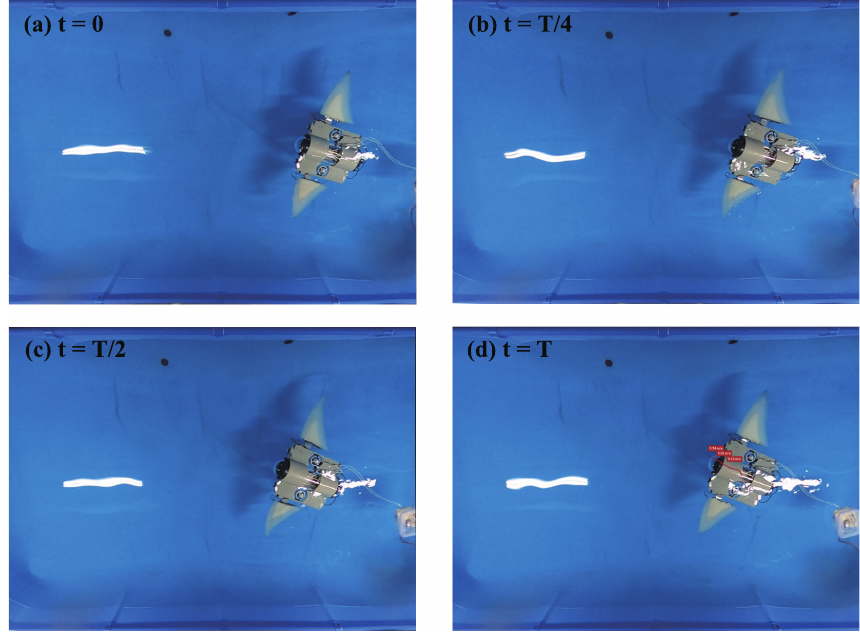
Figure 16. The experiment without in the swimming pool, f = 0.4 Hz, φ 0 = 25, θ 0 =